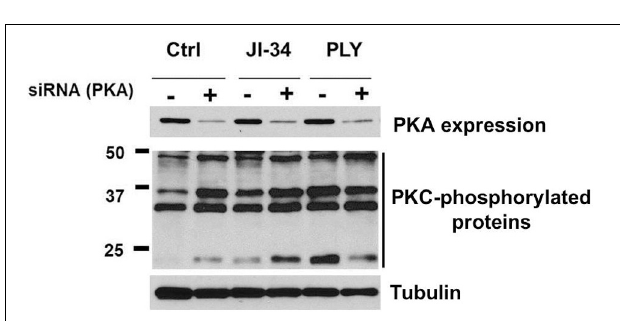
FIGURE 9 | Representative WB of the influence of PKA- α catalytic subunit siRNA-mediated gene depletion [depicted as siRNA (PKA)] on basal, JI-34- (1 μ M) and PLY- (30ng/ml) mediated total PKC activation, assessed as phosphorylated PKC substrates.